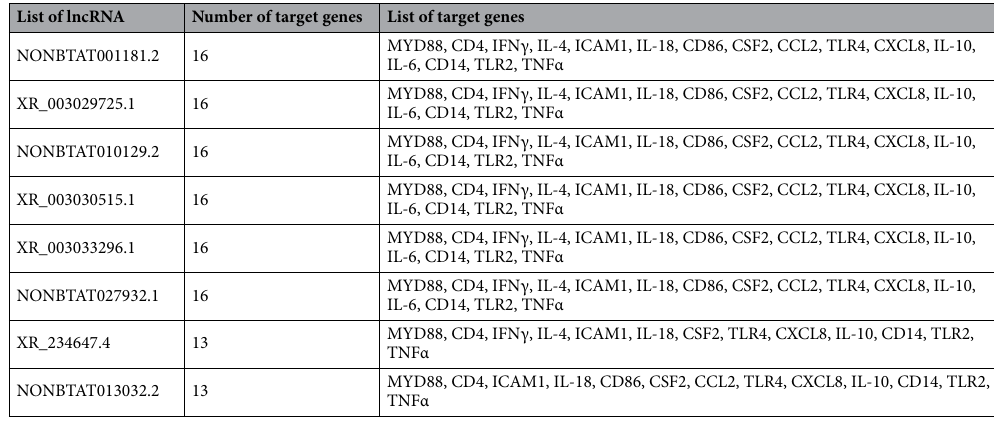
Table 3. Significant lncRNA predicted to target the most candidate